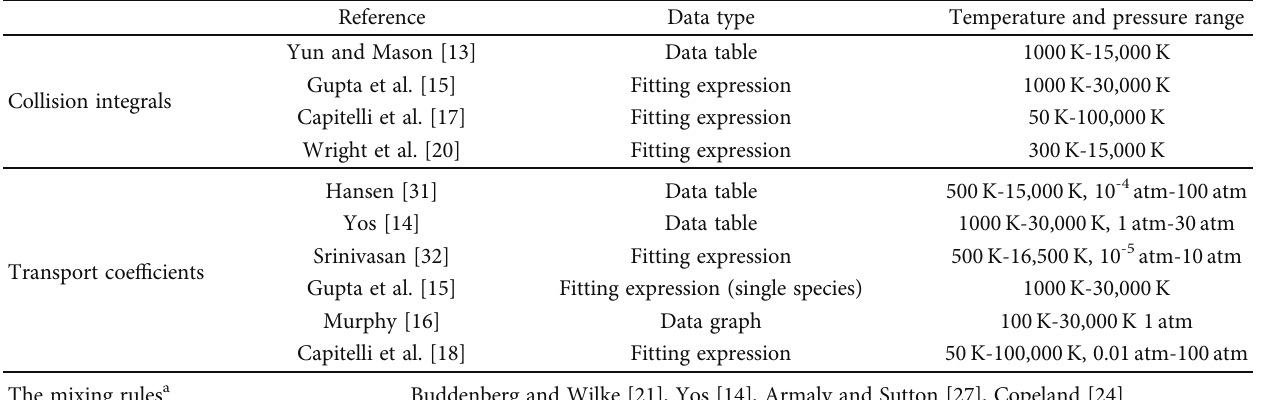
Table 1: Summary of collision integrals and transport coe ffi cients proposed by di ff erent